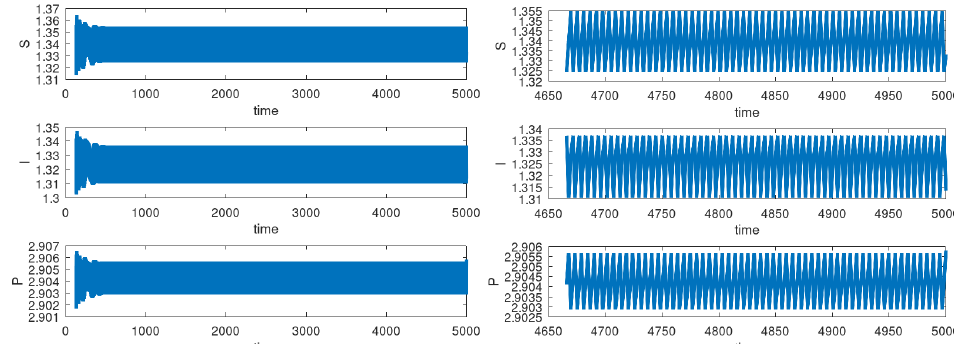
Figure 4. Periodic oscillations (blue lines) are attained with the parameters in (24) and initial condi- tions (25). Left : the time series without the initial transient. Right : the tail of the time series for large times with the simulation being run over [ 0,5000 ] . This indicates that the cycles are persistent. The red dashed line indicates the zero